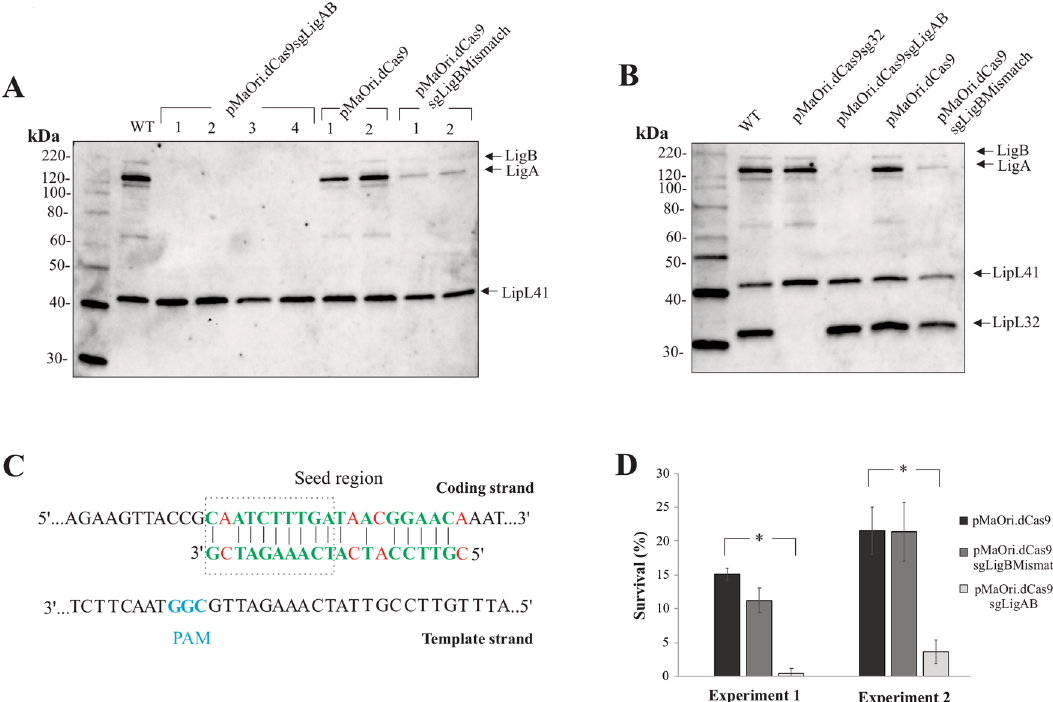
Figure 5. Concomitant LigA and LigB gene silencing reduces leptospiral serum resistance. ( A ) L. interrogans cells were transformed with plasmids pMaOri.dCas9sgLigAB, pMaOri.dCas9sgLigBMismatchControl or pMaOri.dCas9 alone, different colonies were picked, grown in liquid HAN plus spectinomycin and cellular extracts were evaluated by immunoblotting with anti-LigAB and anti-LipL41. ( B ) Representative extracts of each mutant obtained in this work were evaluated by immunoblotting with co-incubation with anti-LipL32, anti-LipL41 and anti-LigA/B. ( C ) Pairing of sgRNA expressed by pMaOri.dCas9sgLigBMismatchControl to L. interrogans ligB coding strand. Matches are presented in green and mismatches in red. Protospacer adjacent motif (PAM) NGG is highlighted in blue. Recombinant cells with different levels of LigA and LigB proteins were challenged with bovine serum (25%) for 2, 4 and 24 h and then plated in duplicate onto HAN plates. Colonies were counted and numbers were compared by Student’s t-test. For each group, the number of cells recovered after incubation with heat-inactivated (HI) serum were considered as 100%